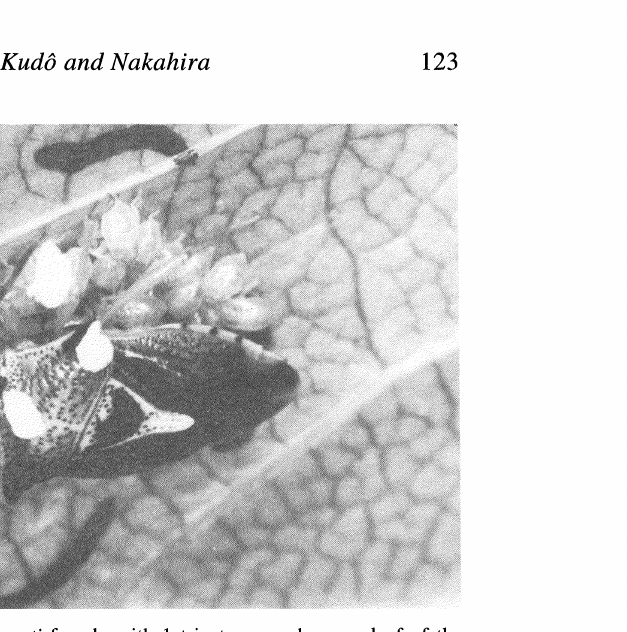
Fig. 1. An Elasmucha signoreti female with st-instar nymphs on a leaf of the host plant, Hydrangea petiolaris. tight aggregation and probably do not feed. After molting to the 2nd instar, nymphs moved from the oviposition site to the inflores- cence in aggregations, to feed on fruit. We observed three marked females straddling newly-molted 2nd-instar nymphs which remained at the oviposition site. However, no females attended 2nd- or later-instar nymphs that had left the oviposition site. In other Elasrnucha spp., parent females often attend the 2nd- or later- instar nymphal aggregation away from the oviposition site (Frost and Haber 1944, Melber and Schmidt 1975a, Honbo and Nakamura 1985, Kud6 et al. 1989). Thus, E. signoreti females probably desert their offspring at the earliest developmental stage among the related species. Five marked females were observed alone on the host at least once after deserting the offspring from the middle to the end of August in 1991. Although males were found on the host before the females disappeared, no copulation was